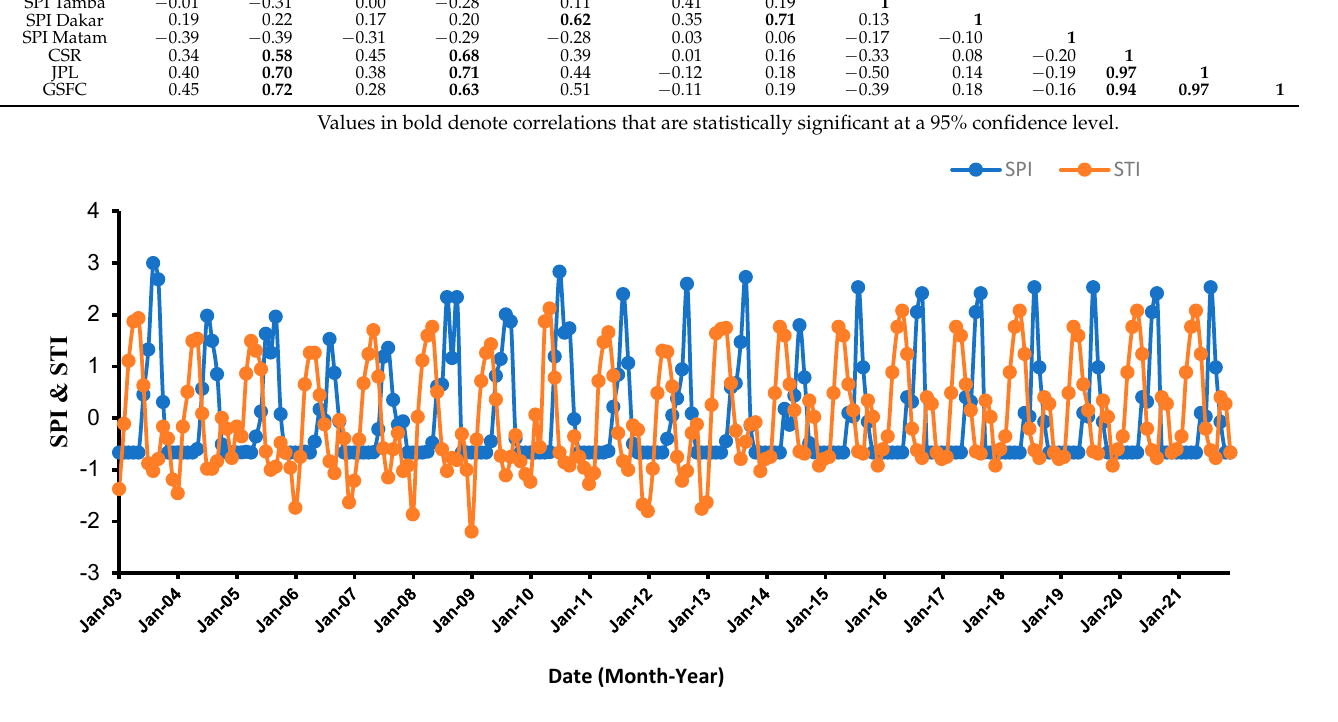
Figure 10. SPI and STI time series over the study area during the entire period. The estimated linear (Pearson) correlations between water storage and climate indices are displayed in Table 2. At the 95% confidence level, the correlation coefficients show